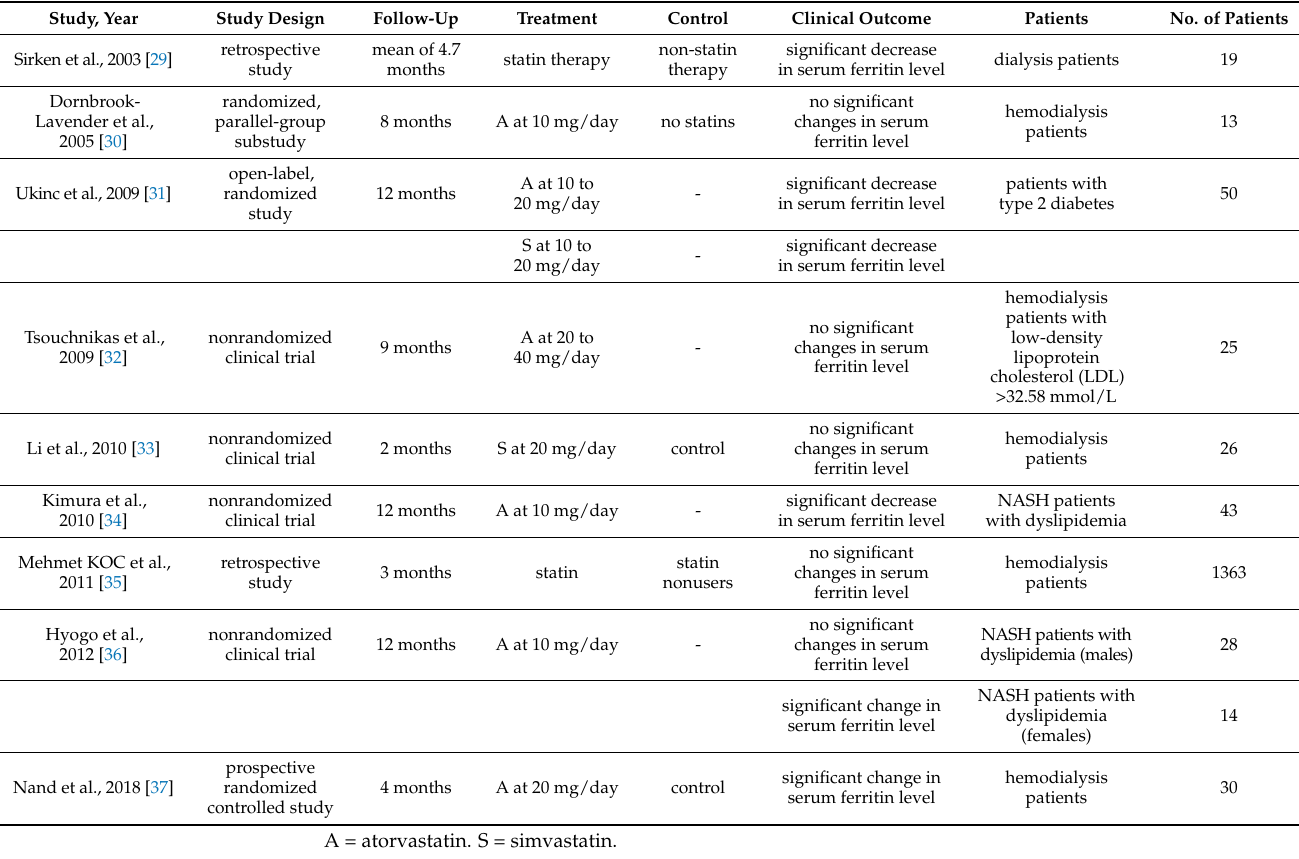
Table 1. Characteristics of studies in which circulating concentrations of serum ferritin were measured.